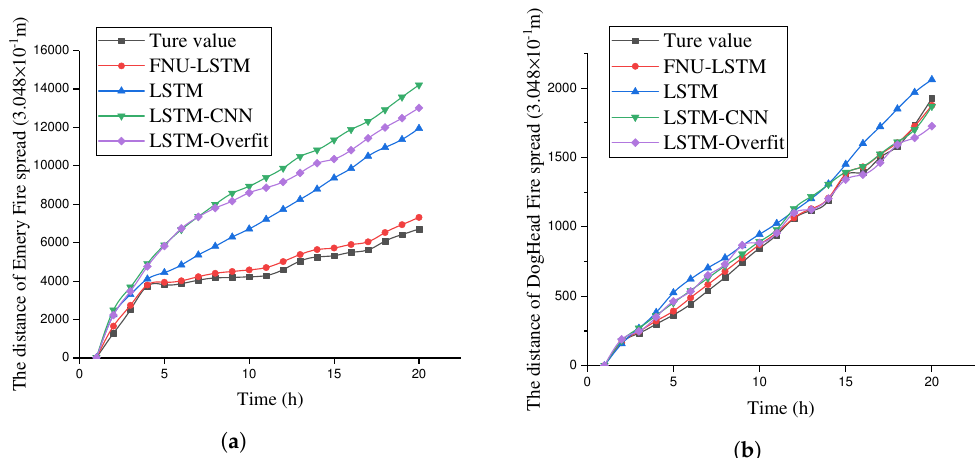
Figure 18. Distance of fores fire spread according to the time. ( a ) The distance accumulated from the fire spread rate predicted on the Emery wildfire. ( b ) The distance accumulated from the fire spread rate predicted on the DogHead wildfire. Table 11. The RMSE value of fire spread distance between models and true value (wildland